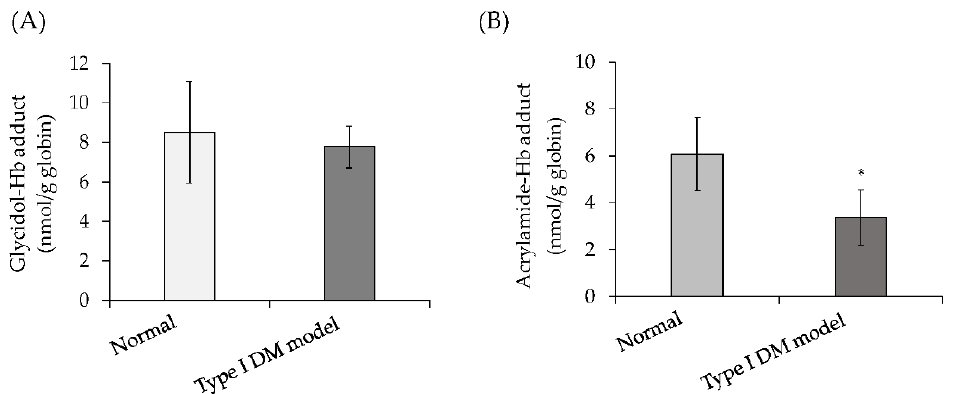
Figure 6. Hb adduct formation in blood from mice with diabetes mellitus (DM) reacted with glycidol or acrylamide (ex vivo). ( A ) Glycidol–Hb adduct formation in blood from the type I DM model mice. ( B ) Acrylamide–Hb adduct formation in blood from the type I DM model mice. * The significance level was p < 0.05 compared with the normal mouse blood. The values represent the mean ± standard deviation (SD) of four independent experiments.